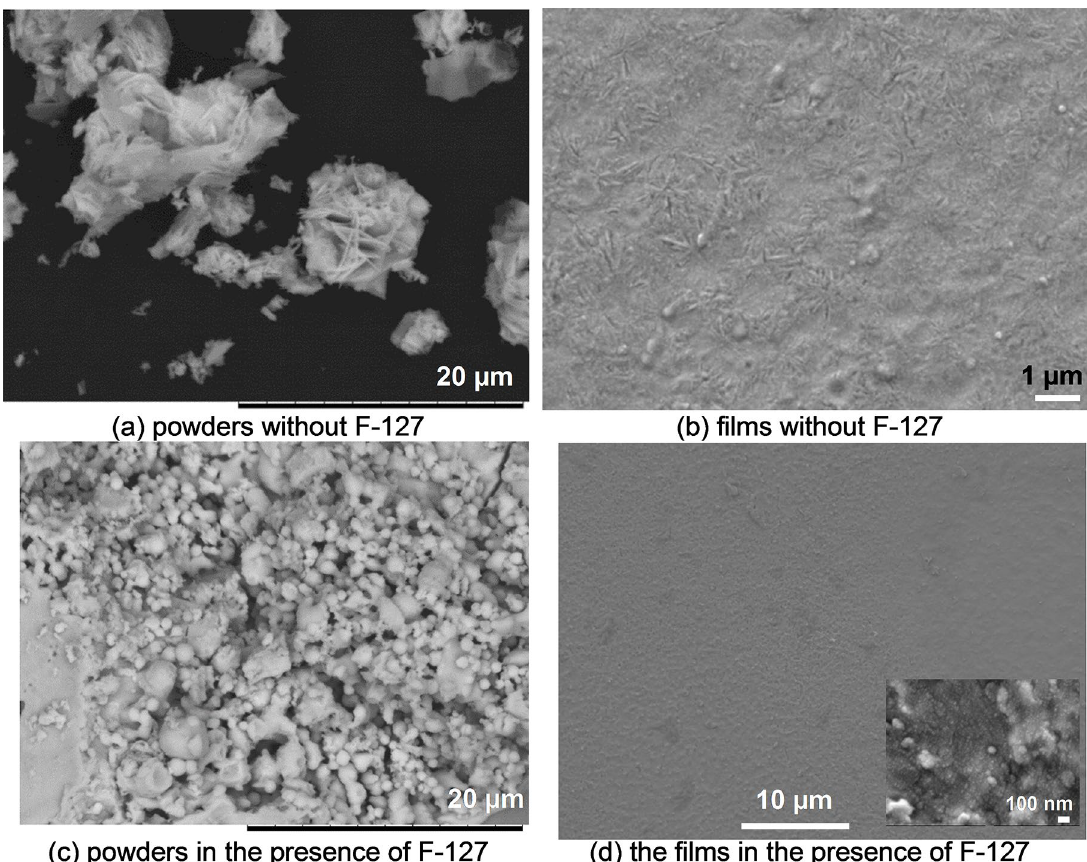
O :Eu 3+ powders and (b) the films without F-127, and (c) the Gd 2 3